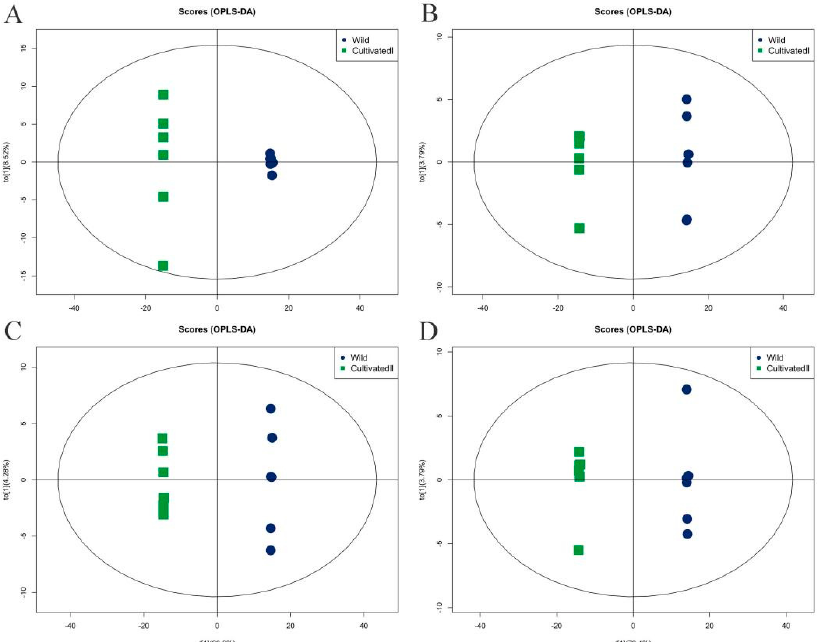
Figure 5. Orthogonal partial least squares discriminant analysis of different origins of YCH. ( A , B ) The score plots of Wild and Cultivated I in the positive and negative ion modes, respectively, with Q 2 of 0.997 and 0.998, respectively. ( C , D ) The score plots of Wild and Cultivated II in the cation and anion modes, respectively, with Q 2 of 0.997 and 0.998, respectively.